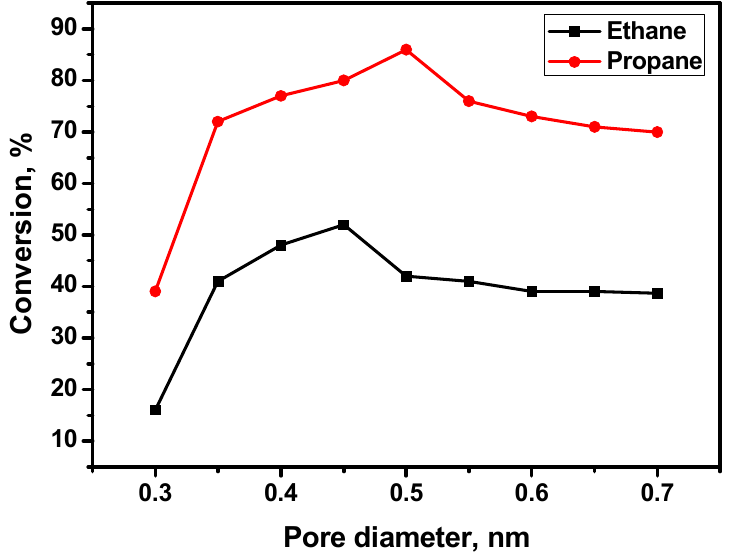
Figure 3. Alkane conversion at the reactor outlet depending on the membrane pore diameter.